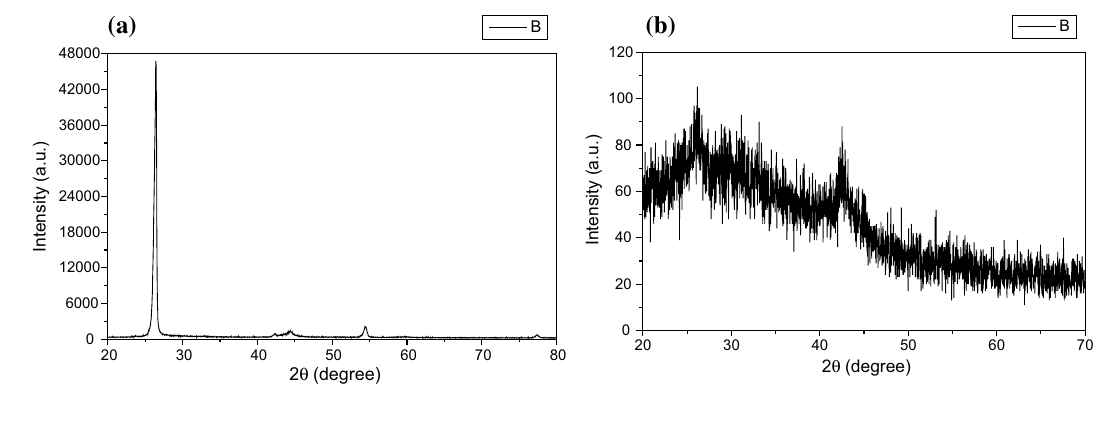
Fig. 3 a XRD of graphite b XRD for GO